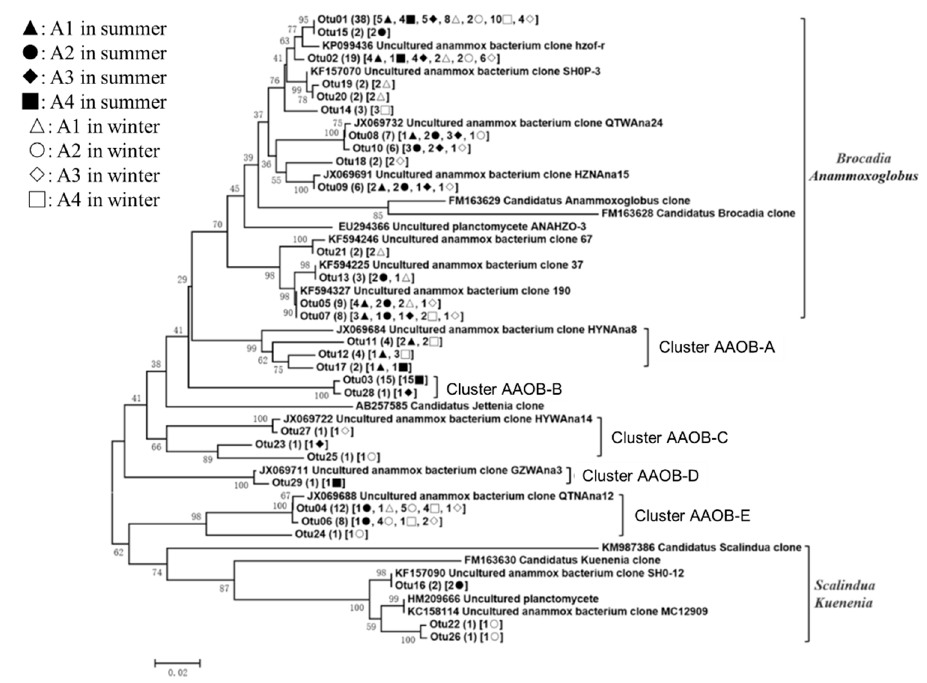
Figure 6. Neighbor-joining phylogenetic tree based on the nucleotide sequences of the hzo gene. The numbers at the nodes represented the credible values that were calculated from 1000-times bootstrap tests. Bootstrap values greater than 20% were shown. The scale bar indicated 0.02 substitutions per nucleotide position. GenBank accession numbers were shown for sequences from other studies. Numbers in parentheses following each OTU indicated the number of sequences recovered from each sampling site.